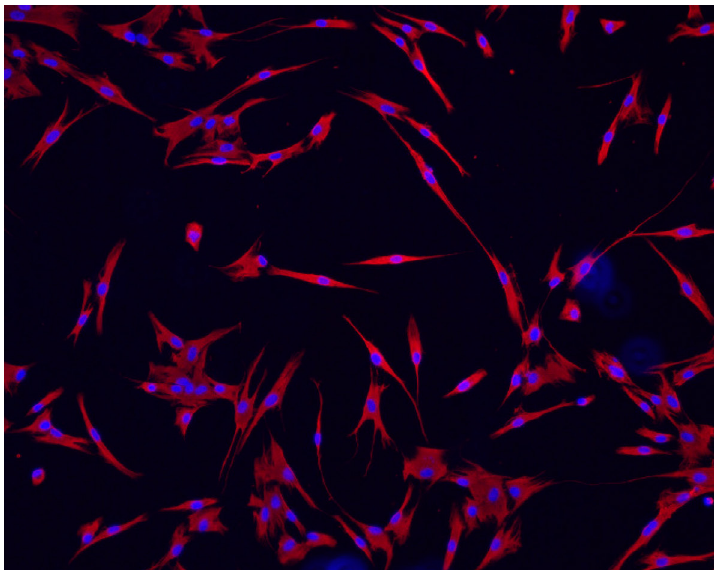
Figure 2- Characterization of human cultured apical papilla cells (APC) by vimentin. Cultured APC were immunostained for vimentin. Image captured by a fluorescence microscope at